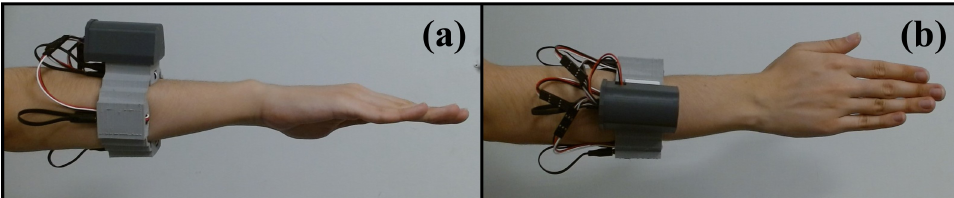
Figure 9. WyoFlex band. ( a ) Lateral view of the location of the Wyoflex band in the forearm, ( b ) Superior view of the location of the Wyoflex band in the forearm.